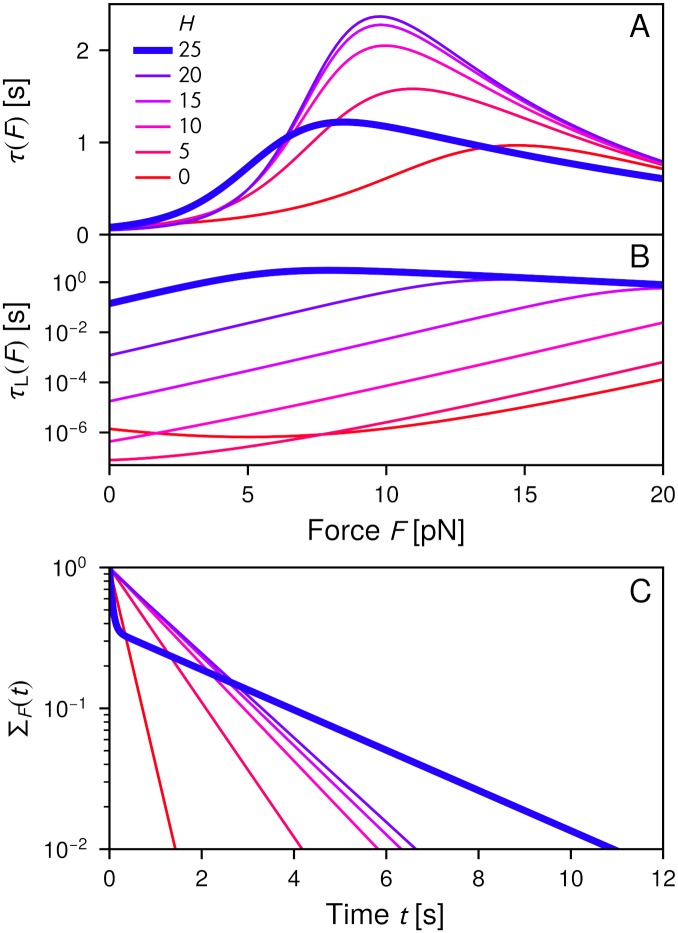
The effects of mutating the angular barrier height H from the original value of 25 kBT down to zero, in increments of 5 kBT, leaving all other model parameters fixed at their Table 1 values: A) the mean bond lifetime τ(F); B) the mean lifetime τL(F) of remaining in the large angle conformational state, α > αc, measured from the initial time of entry into the state; C) the survival probability ΣF(t) at F = 7 pN.